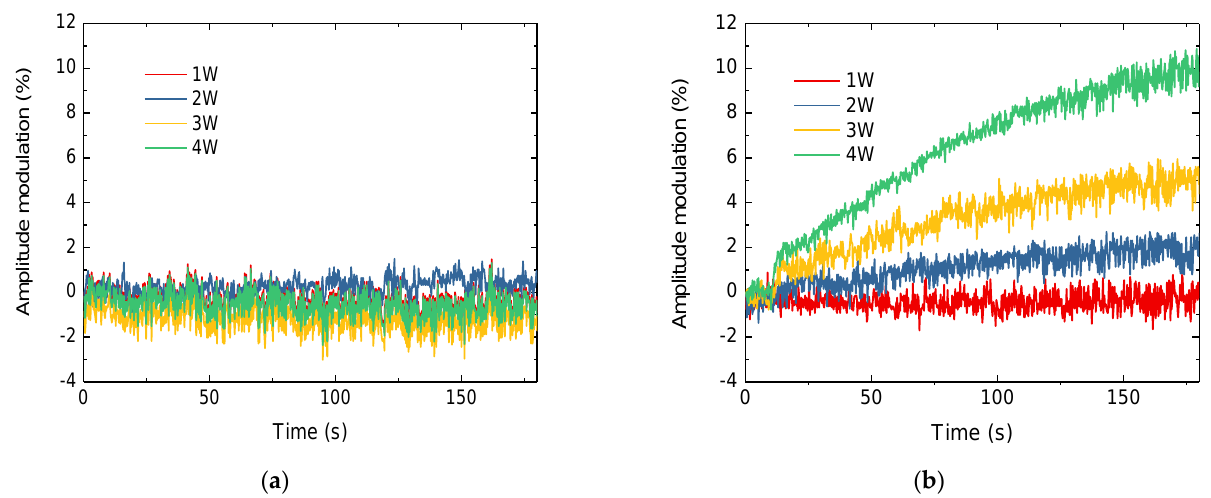
Figure 5. Time sequencing data of the peak-to-peak values of terahertz pulses of ( a ) emeraldine base (EB) and ( b ) emeraldine salt (ES) polyaniline (PANI) solutions exposed to a 35 MeV energy proton beam with a fluence of 10 13 . The laser was irradiated on the solution after 10 s. The legend indicates the power of the continuous-wave near-infrared (CW-NIR) laser with a wavelength of 808 nm.